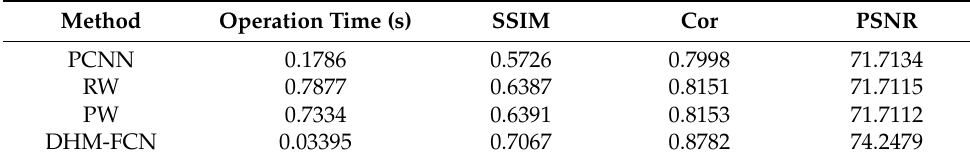
Table 3. Evaluation of indicators for image fusion